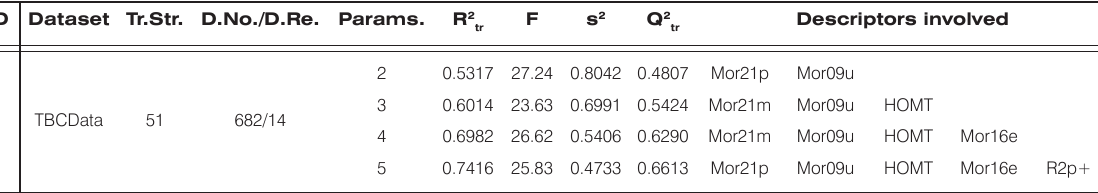
a) MLR models obtained by employing only 3D molecular descriptors (Supporting Information Supplemental Table 3, case 2). ID Dataset Tr.Str. D.No./D.Re. Params.